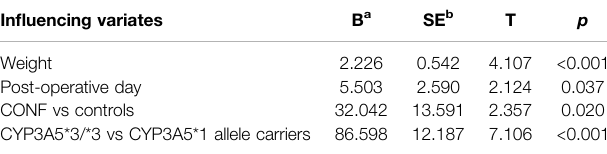
TABLE 4 | The results of stepwise multivariate linear regression